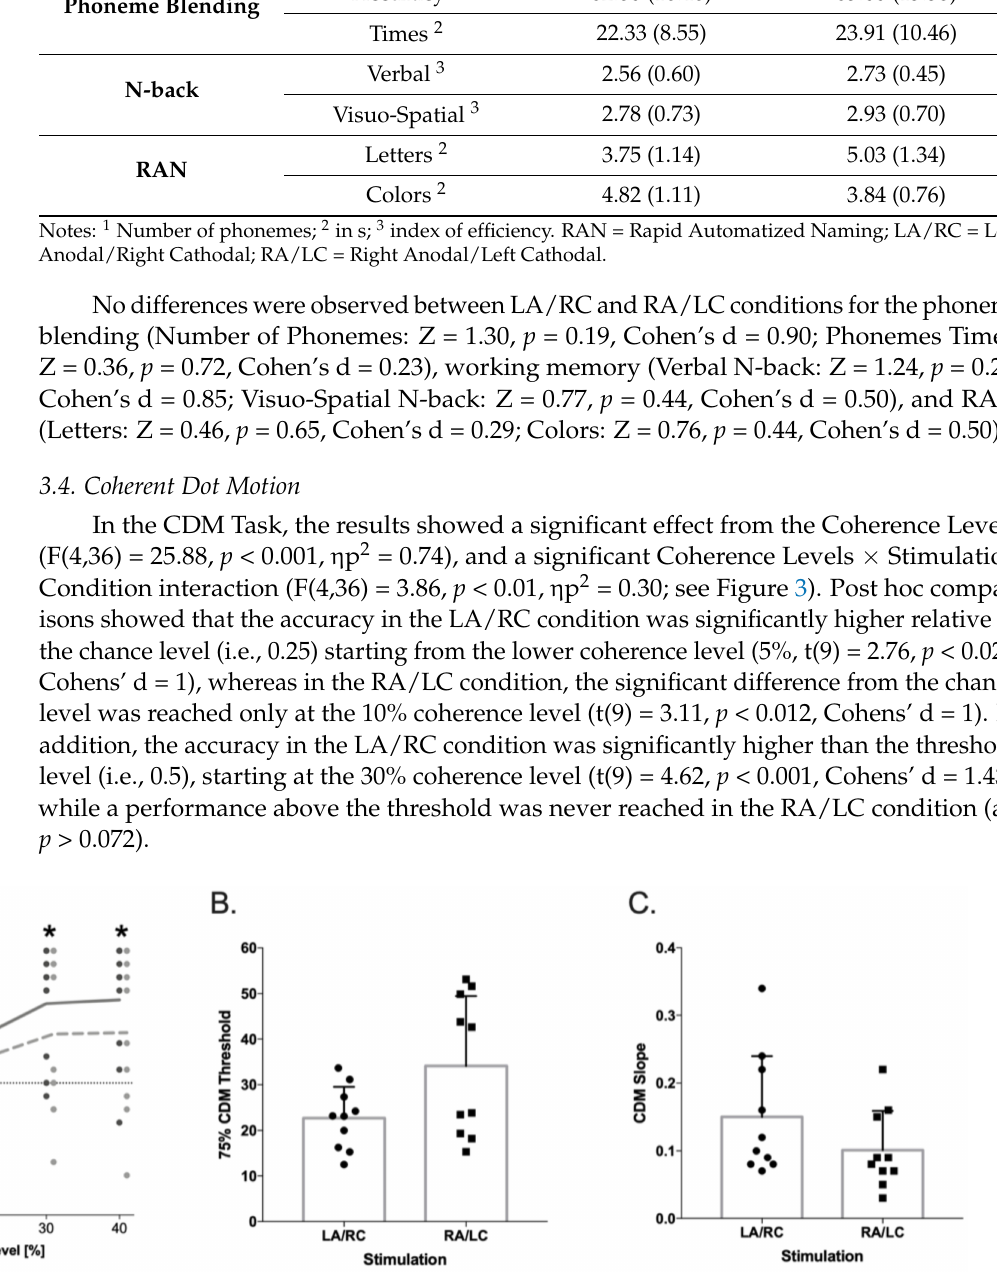
Figure 3. Coherent dot motion (CDM) accuracy (raw data) for the two stimulation conditions; * represents the significant difference from the chance level of 0.25 and from the threshold of 0.5 of accuracy in LA/RC condition. + represents the significant difference from the chance level of 0.25 in RA/LC condition (panel ( A )), p < 0.05 in 75% CDM threshold (panel ( B )), and p < 0.05 in slope values (panel ( C )), as a function of stimulation condition, obtained from the psychometric curve (logistic) fitted on individual data. Dots represent individual data